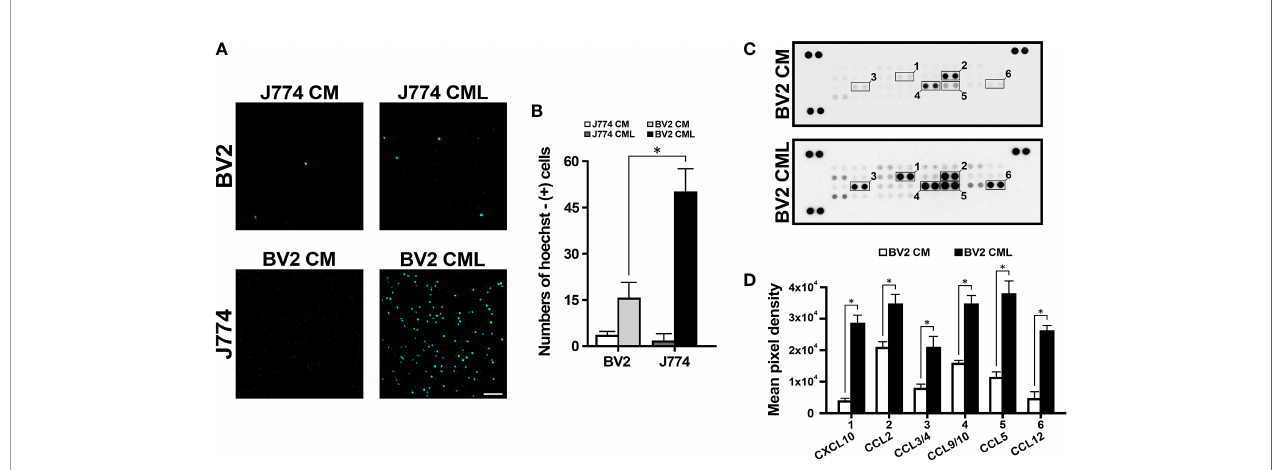
FIGURE 1 | J774 migration induced by BV2. (A) The lower compartment of transwell system showed J774 migration. (B) In CML, the number of migrating J774 cells is more than three times higher than the number of migrating BV2 cells. (C) Representative chemiluminescence images of the proteome pro fi ler array of CM and CML of BV2. The dotted line box indicates the selected candidate chemokines. (D) The quanti fi cation analysis shows the expression of CXCL10, CCL2, CCL3/4, CCL9/10, CCL5 and CCL12 in BV2 CML (n=3/group, *P<0.01, scale bar=10